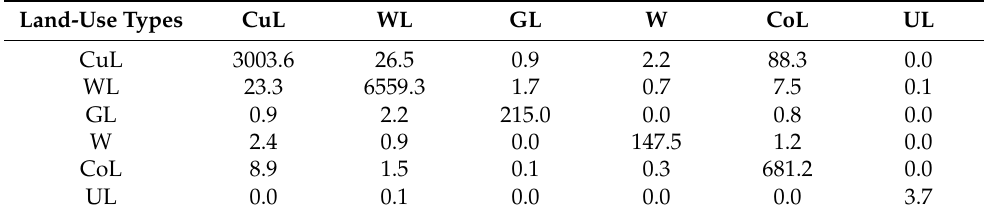
Table 4. Land-use transfer matrix for 2010 to 2015 ( km 2